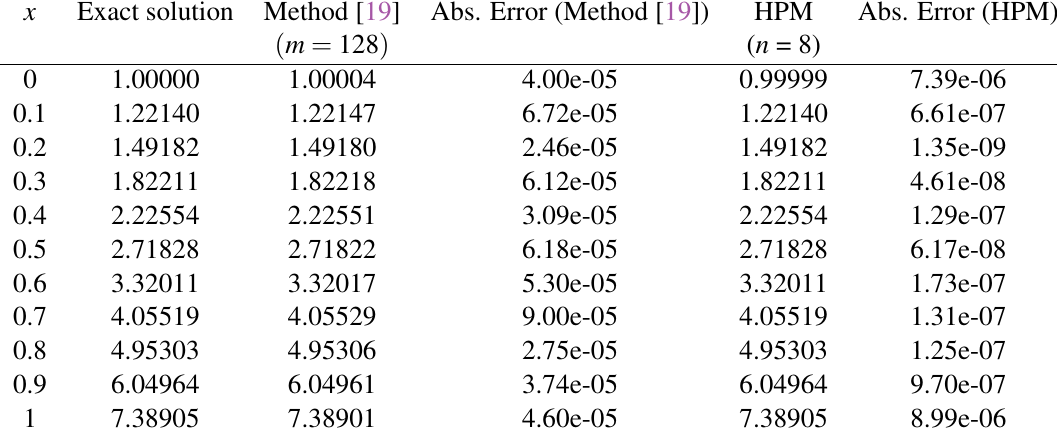
Table 4: Numerical result of Example